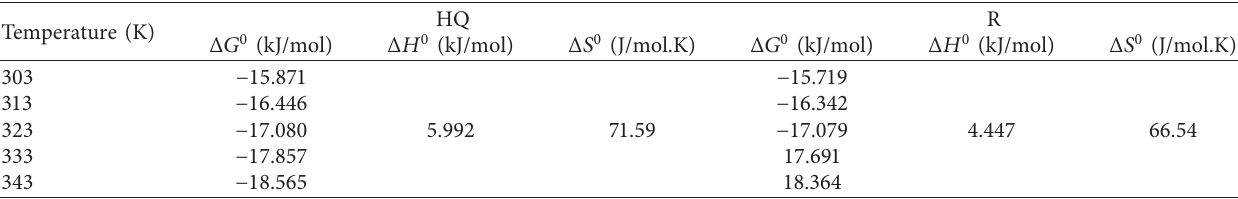
Figure 11: (a) Effect of temperature. (b) Linear plot ln (Kd) versus 1/T of the adsorption of HQ or Table 11: Thermodynamics parameters of the adsorption of HQ and R.